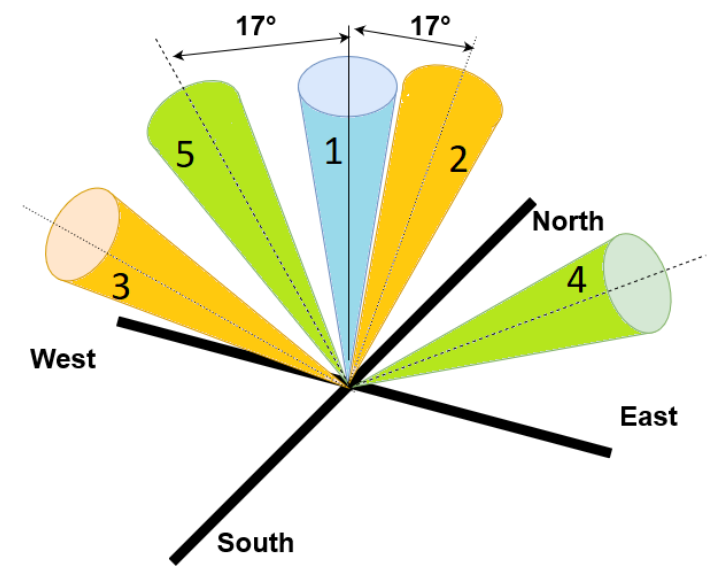
Figure 2. Scheme of wind profiler five-beam configuration with a vertical beam (blue) and four tilted beams oriented towards the four cardinal directions with constant zenithal angle (17°, not to scale). Each beam is numbered according to the labels shown (1, 2, …).